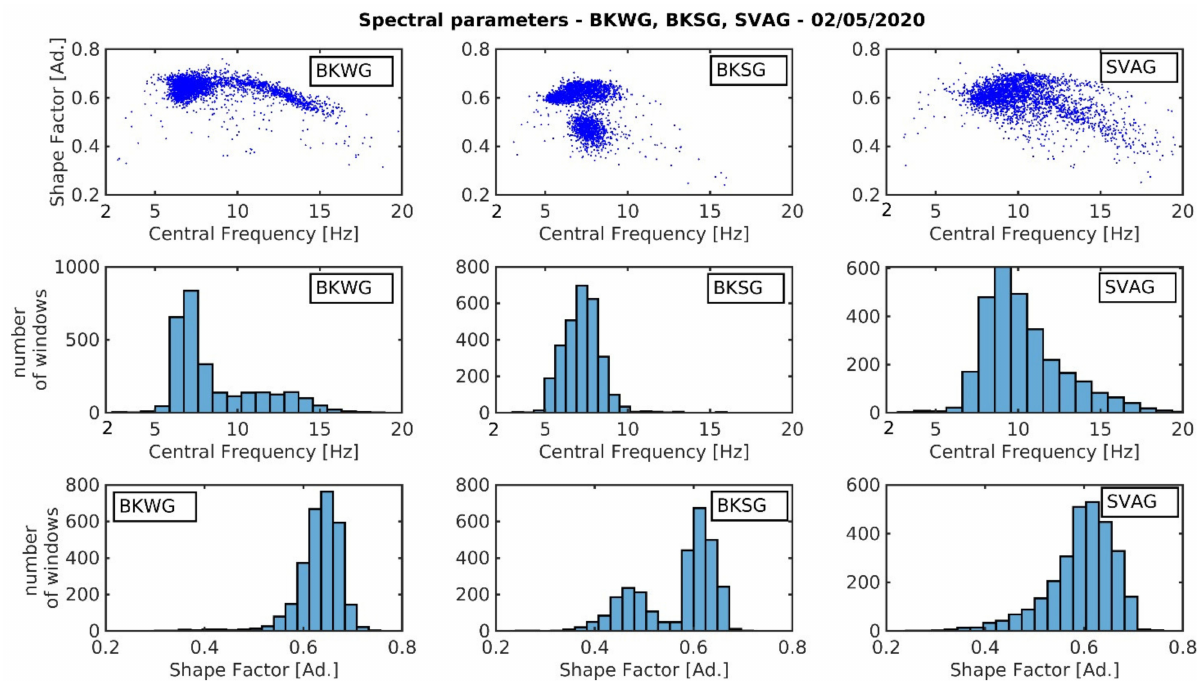
Figure 3. Shape factor and central frequency evaluated on one day of continuous signals recorded on 2 May 2020, at BKSG, BKWG and SVAG mobile seismic stations. In the upper part of the figure, the graphs of the shape factor vs. central frequency are shown, while in the central part and in the lower part, the histograms of the aforementioned spectral parameters are shown for the three selected